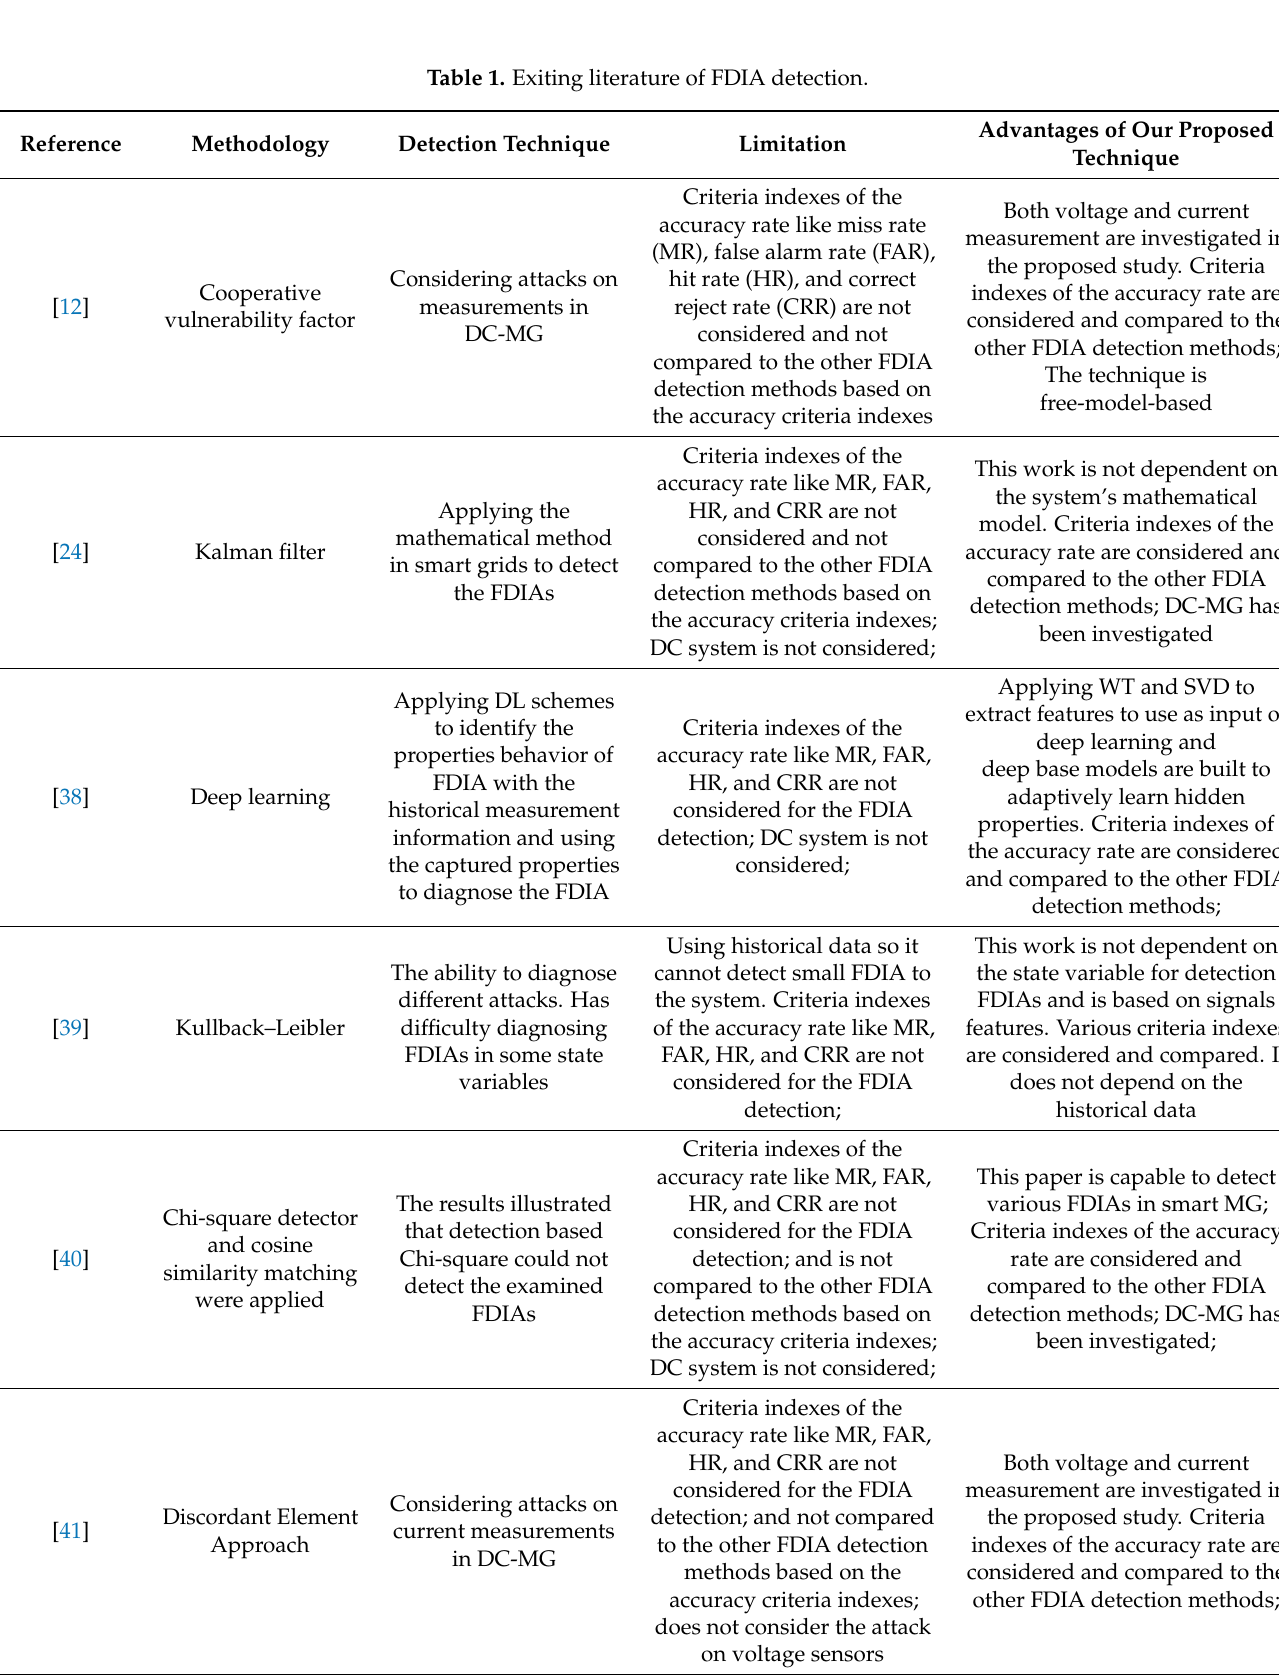
Table 1. Exiting literature of FDIA